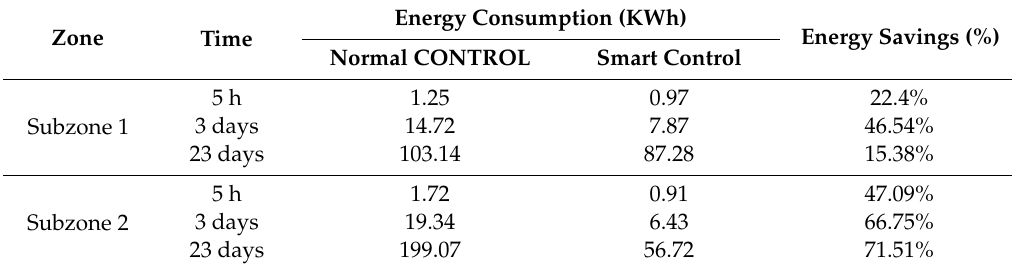
Figure 12. Comparison of energy consumption.